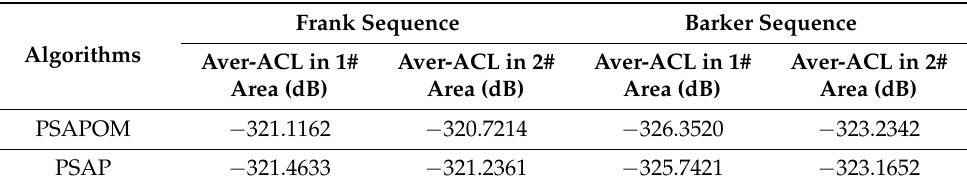
Figure 6. ACL performance comparison for suppressing multiple sidelobe areas. ( a ) Description of PSAPOM and PSAP initialized by Frank-coded sequence; ( b ) Description of PSAPOM and PSAP initialized by the 13 Barker-coded sequence. Table 4. Algorithm (initialized by the Frank or Barker sequence) comparison for suppressing range sidelobes.